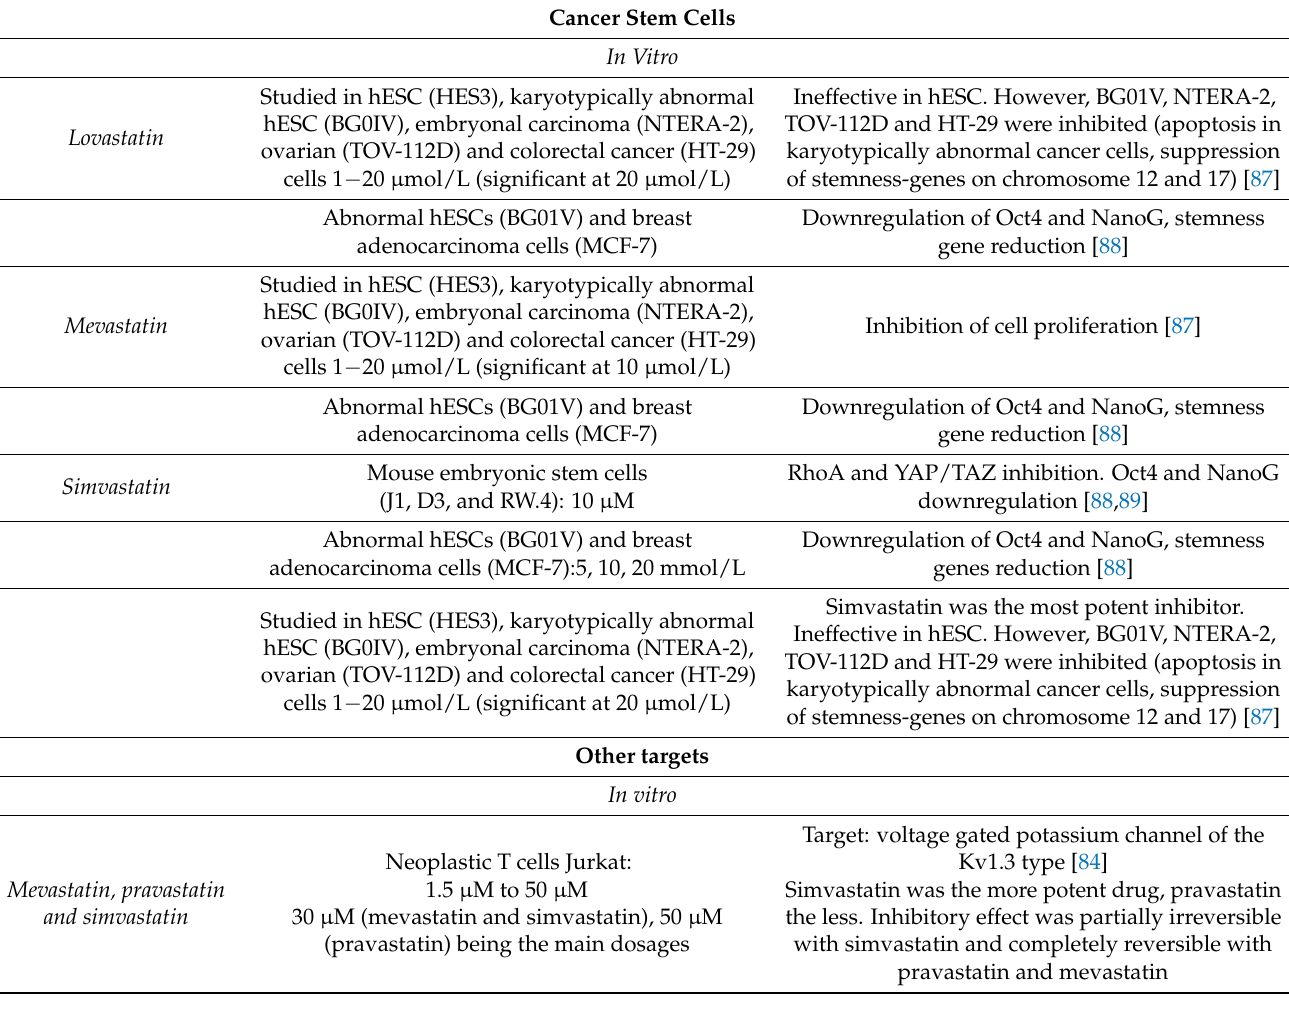
Table 8. Statins’ possible effects on cancer stem cells or other possible mechanisms (further studies needed).